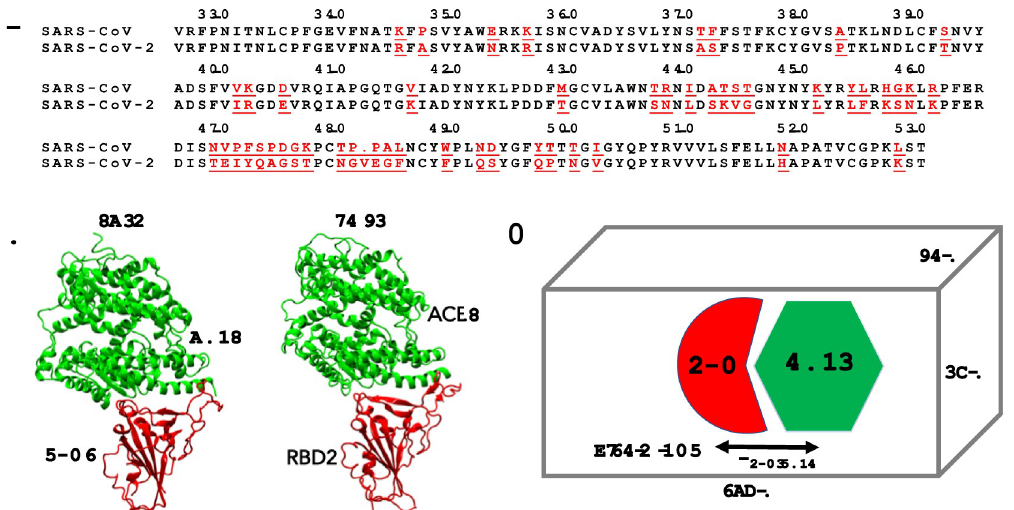
Fig 1. (A) Sequence alignment of receptor binding domains (RBD) of SARS-CoV and SARS-CoV-2. The residues underlined are mutations found in the RBDs. Any residue numbers referred in the text are positions in this sequence alignment. (B) X- ray structures of RBD1 of SARS-CoV (PDB: 2AJF) and RBD2 of SARS-CoV-2 (PDB: 6M0J), respectively, bound to human receptor angiotensin-converting enzyme 2 (ACE2). (C) MD simulation setup for RBD1-ACE2 and RBD2-ACE2